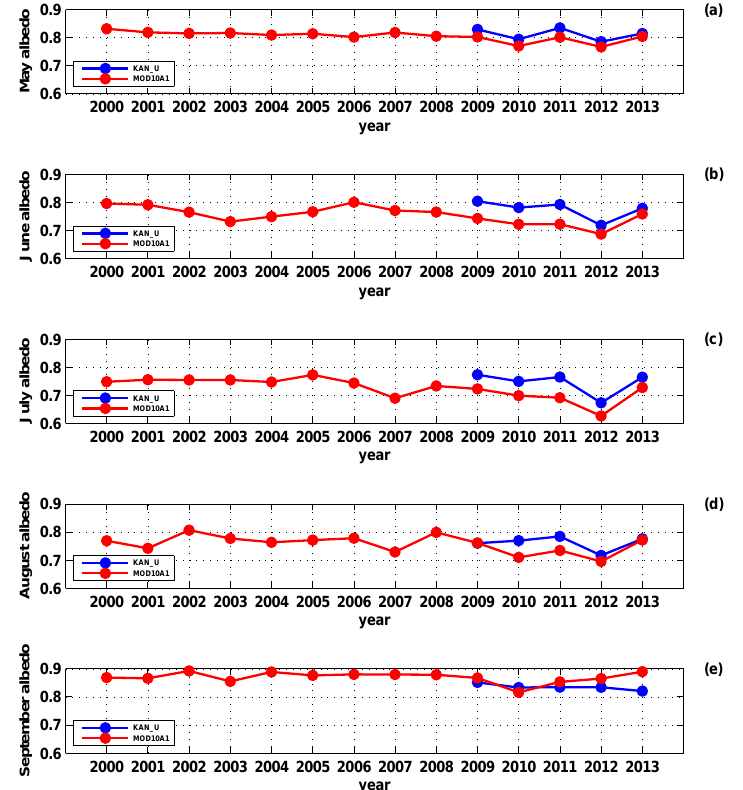
Figure 13. Eleven-day Gaussian filtered nearest neighbour 5 × 5km MOD10A1 albedo (2000–2013) and KAN_U (2009–2013) albedo for the months: (a) May ( R = 0.91, ( (cid:49)α) avg =− 0.02, RMSD = 0.02), (b) June ( R = 0.77, ( (cid:49)α) avg =− 0.05, RMSD = 0.05), (c) July ( R = 0.95, ( (cid:49)α) avg =− 0.05, RMSD = 0.05), (d) August ( R = 0.60, ( (cid:49)α) avg =− 0.03, RMSD = 0.04), and (e) September ( R =− 0.19, ( (cid:49)α) avg = 0.02, RMSD =